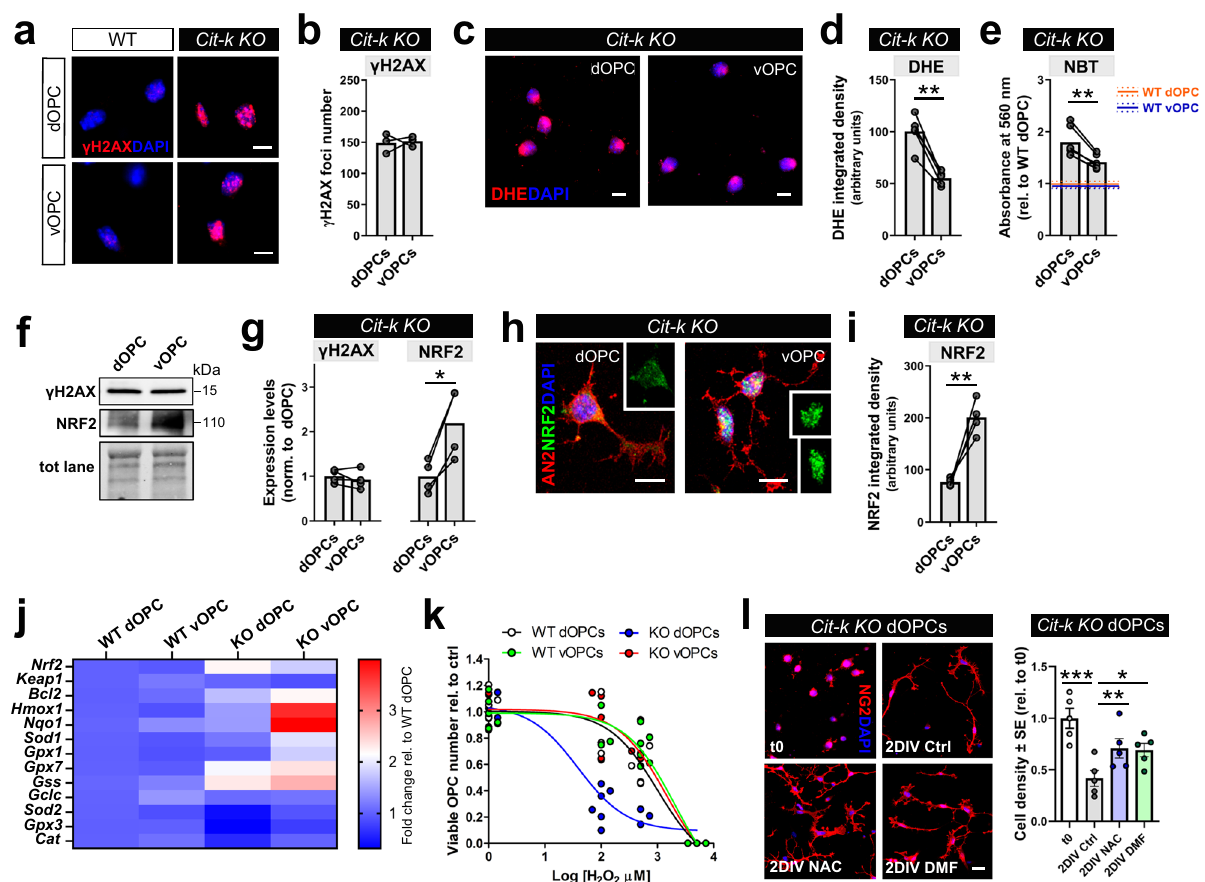
Fig. 6 Cit-k KO dorsal OPCs are more vulnerable to oxidative stress compared to Cit-k KO ventral OPCs. a γ H2AX expression in acutely MACS-isolated OPCs of P10 Cit-k KO mice. b Number of γ H2AX + foci in dOPCs vs. vOPCs ( n = 3 each, two-tailed Mann – Whitney U-test, n.s.). c DHE labeling in acutely MACS-isolated OPCs of P10 Cit-k KO mice. d DHE integrated density in dOPCs vs. vOPCs ( n = 5 each, Two-tailed Paired t -test, ** P = 0.0013, t(4) = 8.043). e NBT reduction assay in Cit-k KO dOPCs vs. vOPCs (normalized to dOPC mean value. n = 4/group, Two-way Anova: Genotype: P < 0.0001, F(1,21) = 92.83; Region: P = 0.0067, F(1,21) = 9.045; Genotype × Region: P = 0.0204, F(1,21) = 6.288). Orange and blue lines represent mean (solid line) ± SE (dotted lines) of WT dOPCs and WT vOPCs, respectively. f , g Western blotting ( f ) and densitometric analysis ( g ) of γ H2AX and NRF2 protein expression in P10 Cit-k KO dOPCs vs. vOPCs ( n = 4/group; γ H2AX: n.s.; NRF2: P = 0.0155, t(3) = 4.984, Two-tailed Paired t -test). h NRF2 (green) expression in MACSorted Cit-k KO AN2 + (red) dOPCs and vOPCs in vitro. DAPI (blue) counterstains cell nuclei. i NRF2 staining integrated density in MACSorted Cit-k KO dOPCs vs. vOPCs ( n = 4/group; P = 0.0087, t(3) = 6.129, Two-tailed Paired t -test). j Heatmap of the qRT-PCR analysis of the mRNAs of Nrf2 , Keap1 , and NRF2-target genes in dOPCs and vOPCs MACSorted from P10 WT and Cit-k KO mice (Two-way Anova followed by Bonferroni ’ s Multiple Comparison Test; n, P, and F values in Supplementary Table 1). Dot plots are included in Supplementary Fig 7. k Log(inhibitor) vs. response curve (Non-linear regression inhibition curve) representing percentages of viable OPCs after an acute H 2 O 2 treatment (0, 100, 500, 5000 µ M). LC50 KO dOPCs = 38.96 µ M, R 2 = 0.885; LC50 KO vOPCs = 1481 µ M, R 2 = 0.859; LC50 WT dOPCs = 1015 µ M, R 2 = 0.895; LC50 WT vOPCs = 2046 µ M, R 2 = 0.907). l Cit-k KO dOPC density at t0 (i.e., 30 min after plating) and at t = 2 DIV in Ctrl conditions vs. in presence of NAC or DMF ( n = 5/group; P < 0.0001, F(3) = 53.86, One-way Anova Repeated Measures). In l data are mean ± SE. In b , d , e , g , i lines connect paired samples (i.e., dOPC and vOPC samples from the same mouse). Scale bars: 5 µ m in a , c , h ; 10 µ m in l . DHE dihydroethidium, DIV days in vitro, DMF dimethyl fumarate, dOPC dorsal oligodendrocyte progenitor cell, H 2 O 2 hydrogen peroxide, LC50 inhibitory concentration 50 — concentration that produces 50% decrease in viable cells, NAC N-acetyl-L-cysteine, NBT Nitroblue Tetrazolium, vOPC ventral oligodendrocyte progenitor cell, WT wild-type; P postnatal day, γ H2AX phosphorylated histone H2AX. * P < 0.05; ** P < 0.01; *** P < 0.001. Source data are provided as a Source Data fi